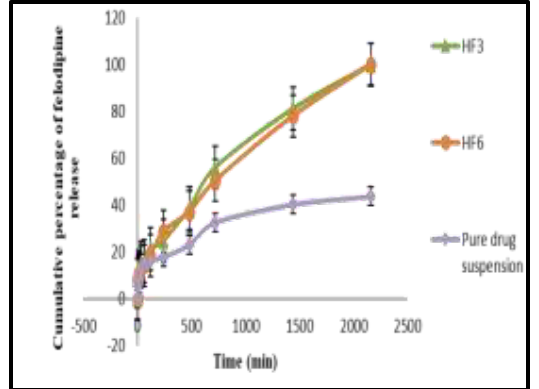
Figure 6. In vitro felodipine release profile from LPHNs formulations HF3,HF6 and the pure drug suspension at phosphate buffer pH 6.8 + 0.3 % polysorbate 80